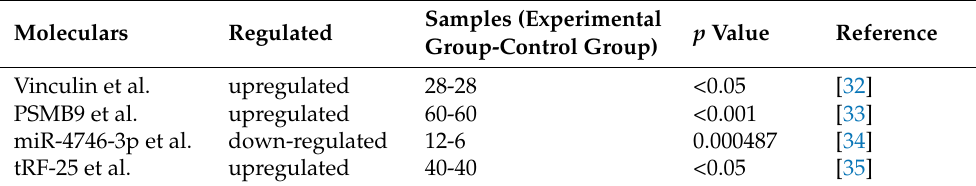
Table 1. EVs as potential diagnostic tool in